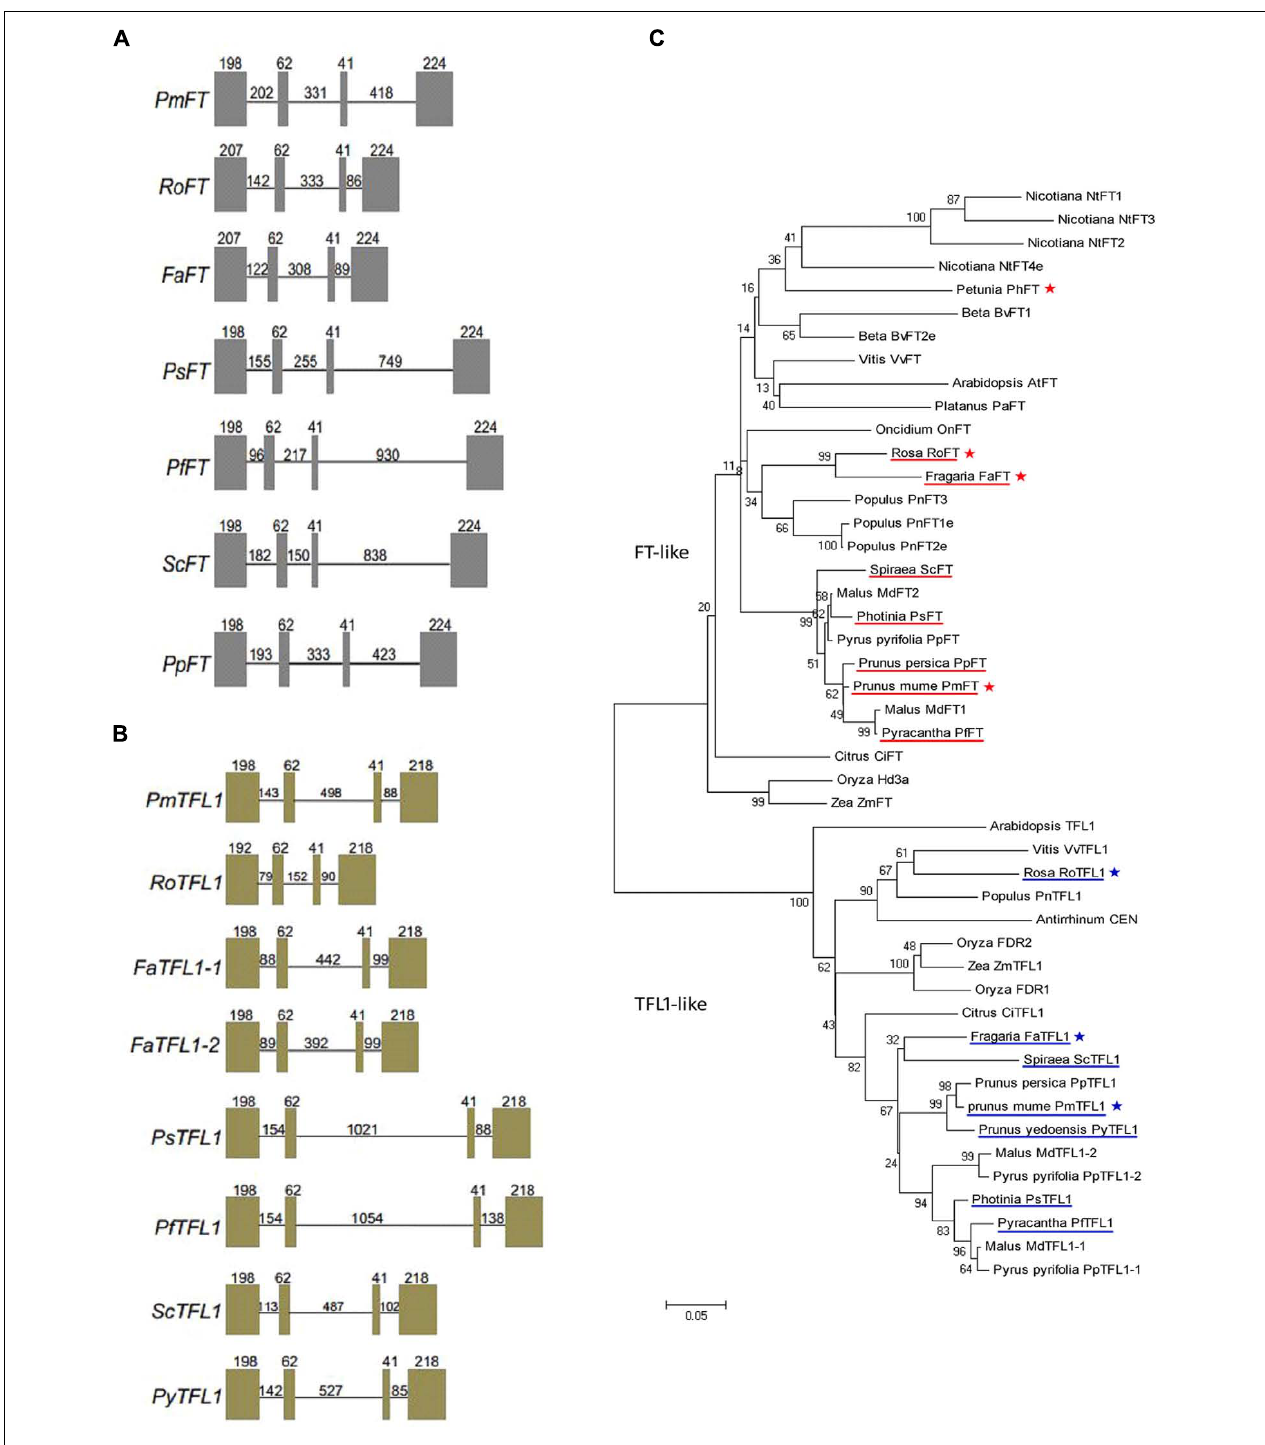
FIGURE 1 | Gene structures and phylogenetic analysis of the FT/TFL1 homologs. Gene structures of: (A) FT and (B) TFL1 homologs isolated from eight Rosaceae species including Prunus mume ( PmFT ) , Rosa ( RoFT ) , Fragaria ( FaFT ) , Photinia (PsFT), Pyracantha (PfFT), Spiraea (ScFT), Prunus persica (PpFT); Prunus mume (PmTFL1), Rosa (RoTFL1), Fragaria (FaTFL1), Photinia (PsTFL1), Pyracantha (PfTFL1), Spiraea (ScTFL1), Prunus yedoensis (PyTFL1) . Boxes indicate exons and lines indicate introns; the numbers represent their corresponding lengths (bp). (C) Phylogenetic analysis of the FT/TFL1 homologs from different plant species. Under-lined genes represent FT/TFL1 homologs isolated from Rosaceae species and asterisks represent gene sequences used for function identification in this study.